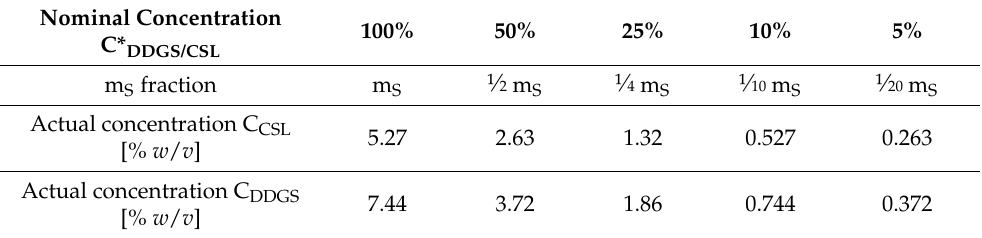
Table 3. Nominal concentrations C* of one-component media and their chemical equivalents.